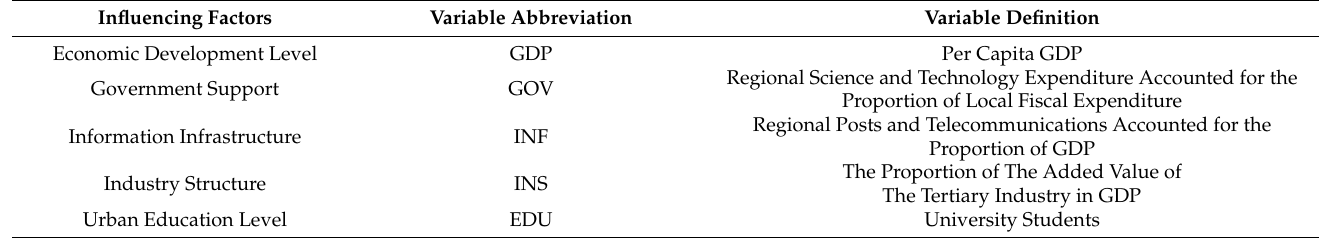
Table 2. Influencing factors and variables of green innovation efficiency.